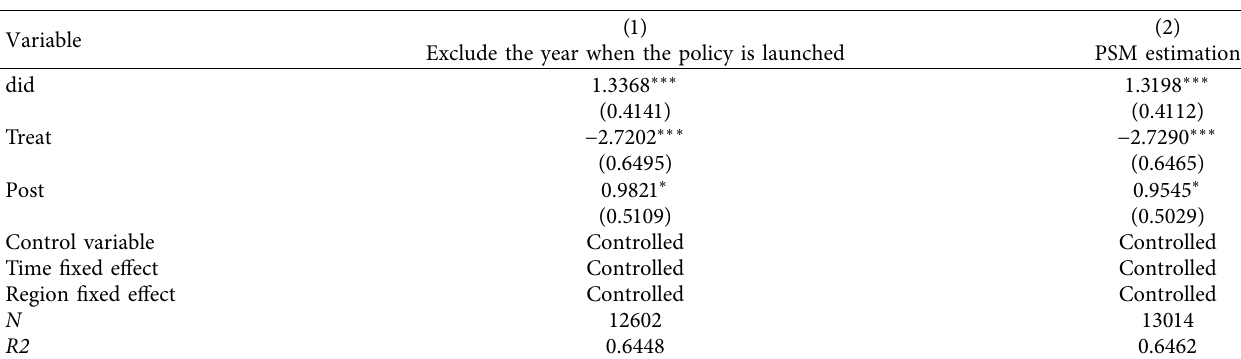
Table 3: Robustness test.